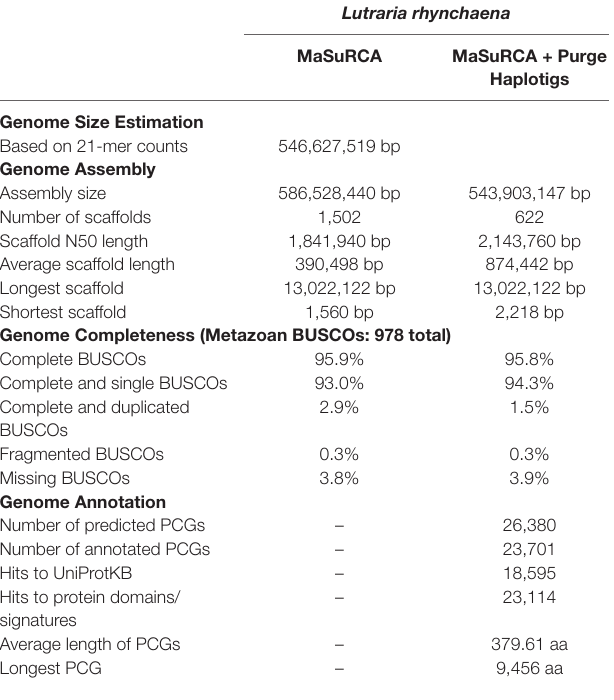
TABLe 1 | Summary of assembly and annotation of the snout otter clam